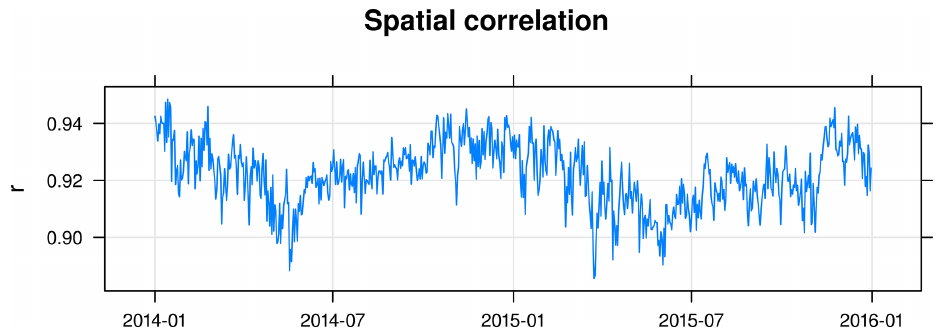
Figure 3. Spatial correlation of predicted and observed volumetric soil moisture throughout the test period.